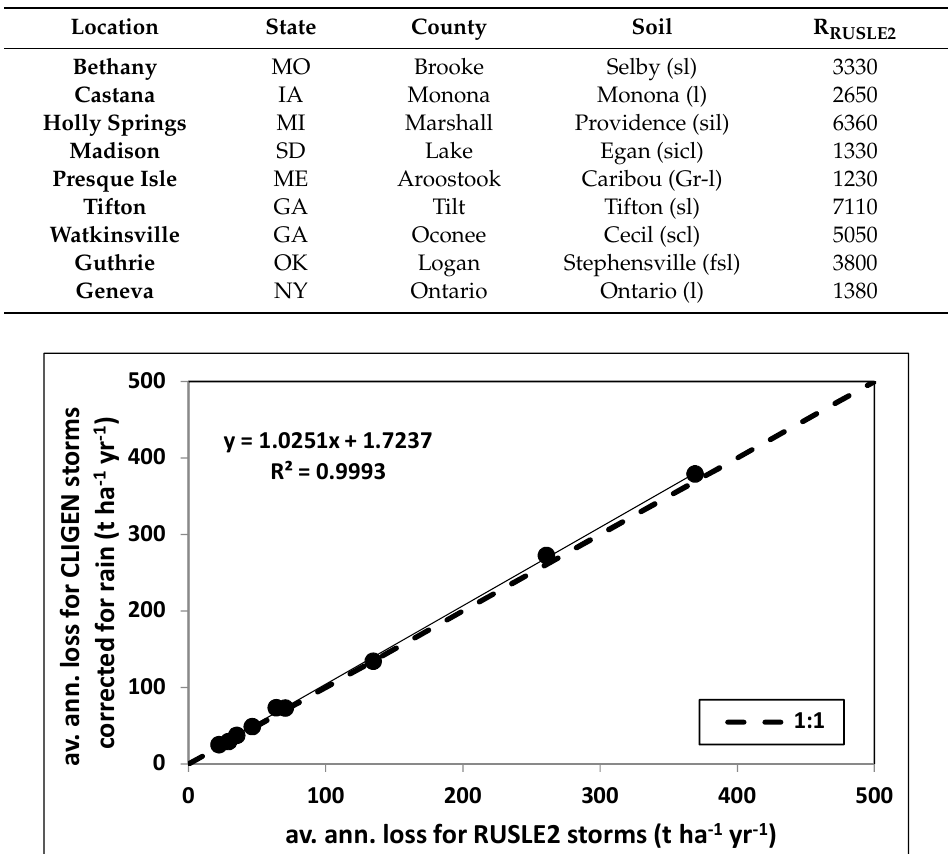
Figure 8. Relationship between average annual soil loss produced by CLIGEN storms and average annual soil loss produced by RUSLE2 storms at the nine locations when the revised erosivity density values were used to predict event erosivity when rainfalls of less than 12.5 mm were omitted (source: Kinnell [55]). Table 2. RUSLE2 R factor and soils at the locations with unit plots where CLIGEN was used as a weather generator for RUSLE2. IA: Iowa, MI: Michigan, SD: South Dakota, OK: Oklahoma, NY: New